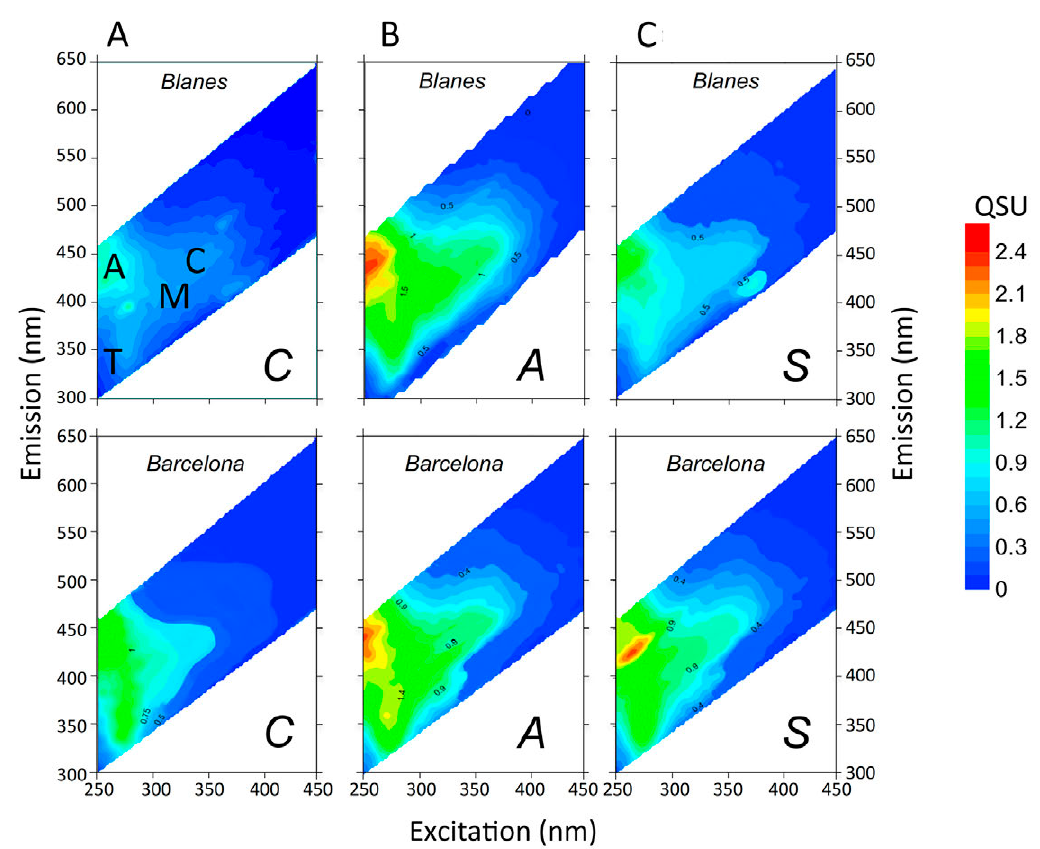
Fig. 5. – Changes in the excitation-emission matrix (EEM) of FDOM after dust addition in the two experiments. Before addition ( C ) in column A, and after additions of anthropogenic aerosols ( A ) in column B and Saharan dust ( S ) in column C. The different peaks are indicated. The fluorescence is expressed in quinine sulphate units